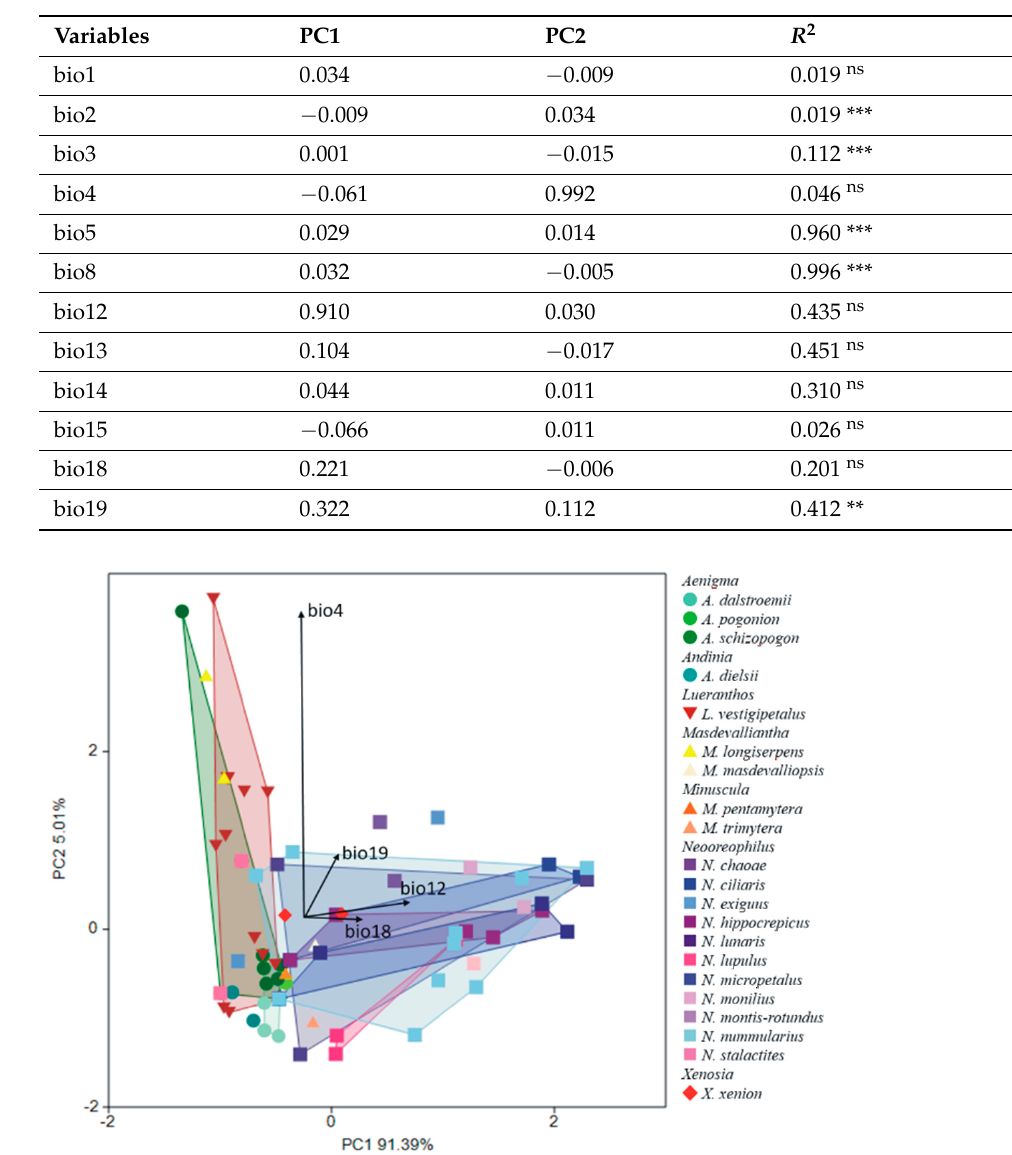
Figure 10. Principal component analysis (PCA) of the climatic variables present in the studied spe- cies. Variables with the greatest contributions are presented as vectors.